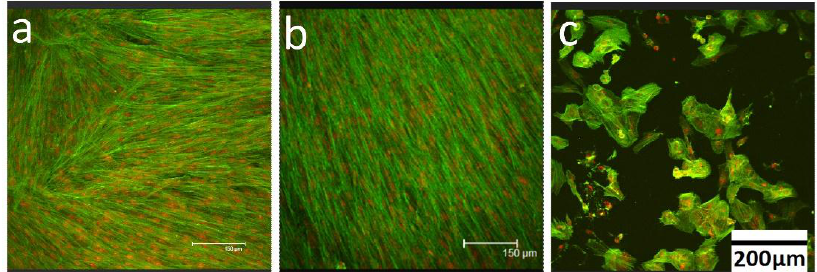
Figure 3. Dental pulp stem cells (DPSC) were plated on tissue culture plastic at a density of 10,000 cells/cm 2 , stained with Alexa Flour 488 (green) for actin filaments and Propidium Iodide (red) for nucleus and imaged with confocal microscopy after being cultured for ( a ) 4 days; ( b ) 6 days; and ( c ) 6 days with 0.05 mg/mL ZnO nanoparticles added at day 5.